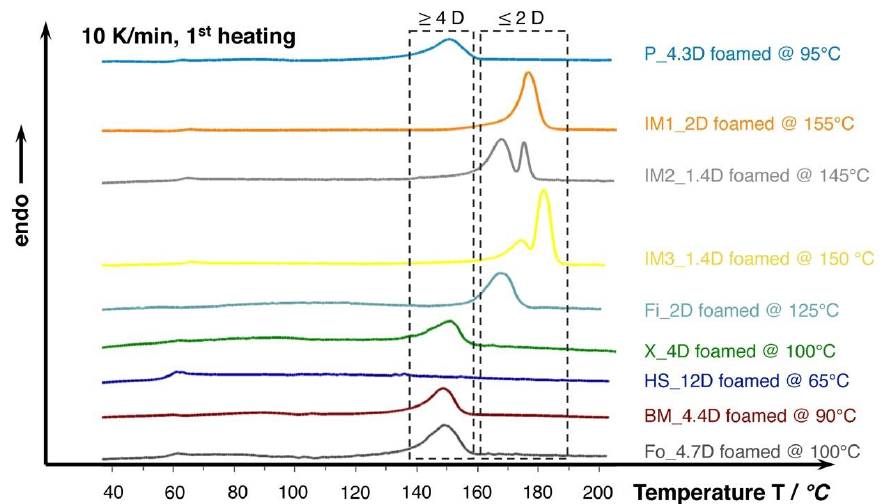
Figure 7. DSC curves (10 K / min., 1 st heating) of the lowest density foams achieved in batch foam experiments with 30 min. saturation at 180 bar. Note the increased melting temperatures marked in the dashed boxes of PLA foams with lower D-content of 2 and 4, respectively.